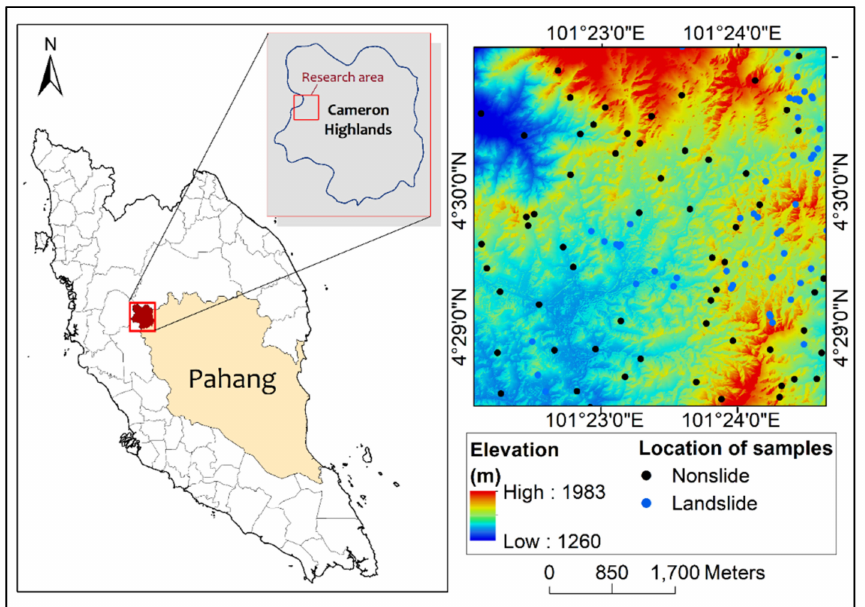
Figure 1. Maps of the study area and the historical landslide events (located within Cameron Highlands,